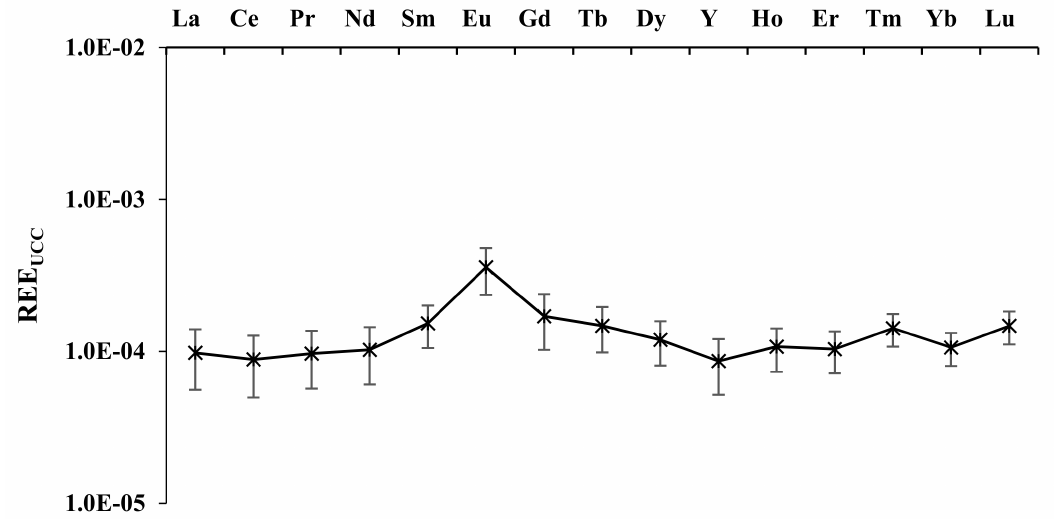
Figure 3. UCC-normalised REE pattern of Campo Carboj olive samples (averaged values with standard deviation for all